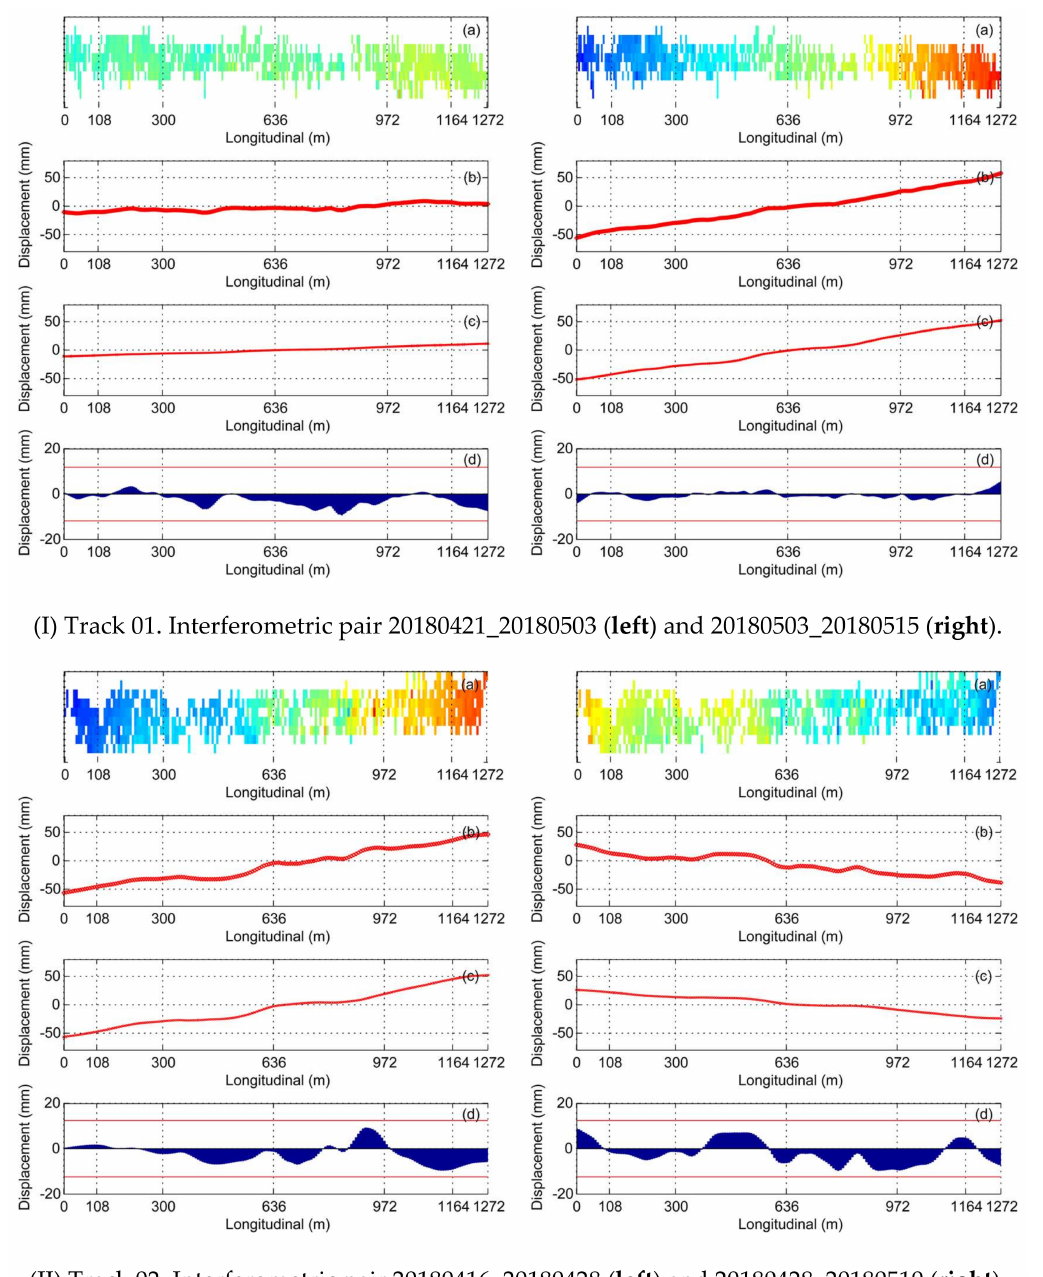
Figure 14. NDHRB health evaluation using the proposed method for the two tracks. From top to bottom of each interferometric pair: longitudinal displacement interferometric measurements, averaged cross values, modeled value, and difference between the measurement and the modeled